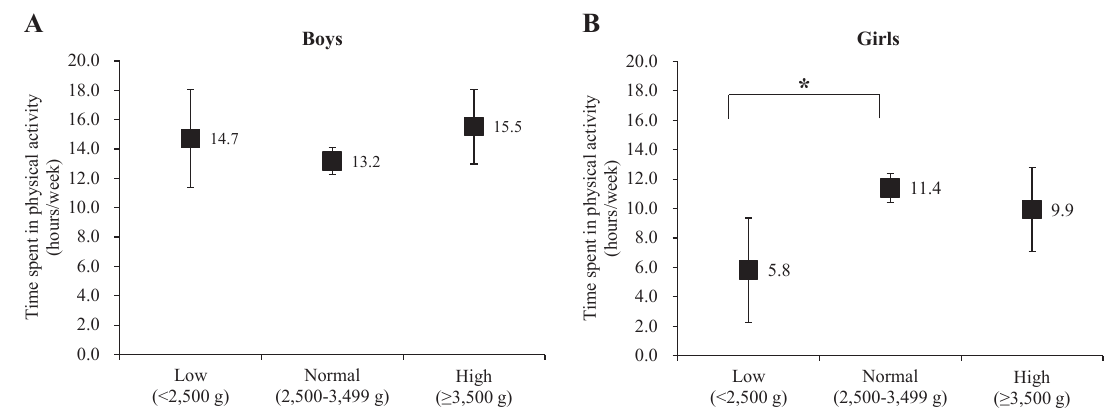
Figure 1. Association between birth weight categories and physical activity time in boys (A) and girls (B). Each plot is presented as estimated marginal means (standard error). Physical activity time was adjusted for age in months, age- and sex- speci fi c body mass index category (overweight or non-overweight), gestational age, and parental education level using analysis of covariance. * indicates the signi fi cance of Low versus Normal (mean di ff erence, % 5.57; 95% con fi dence interval, % 10.1 to % 1.04, P = 0.010; Cohen ’ s e ff ect size (d) =